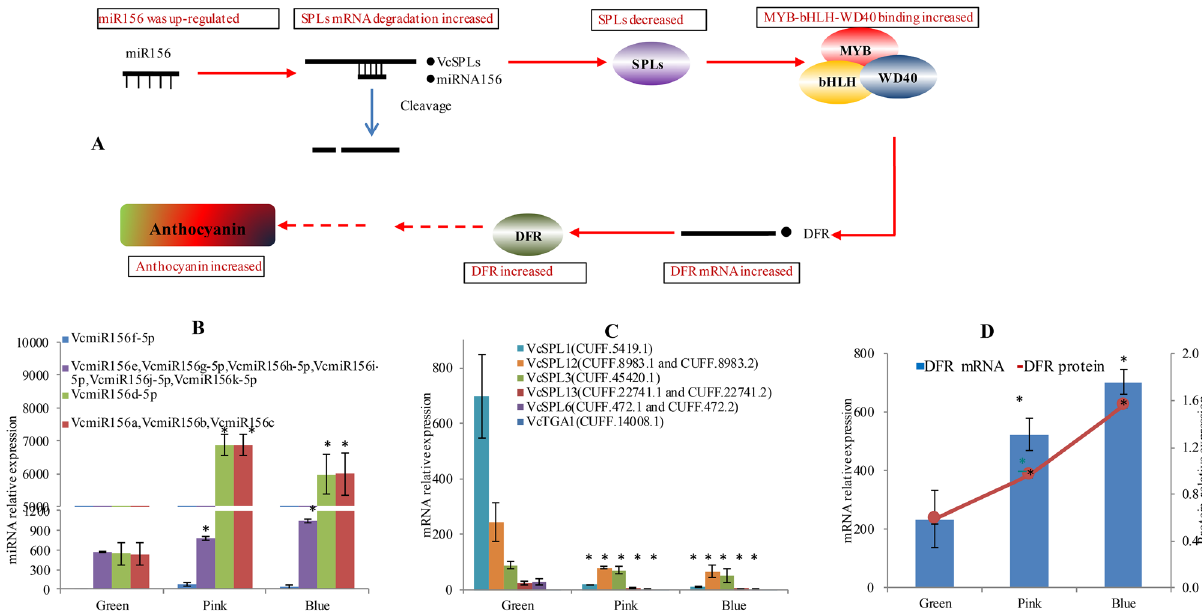
Figure 2. A potential pathway of the miR156-SPL module involved in anthocyanin biosynthesis during fruit maturation. (A) VcmiR156-VcSPLs regulated dihydroflavonol 4-reductase (DFR), a gene responsible for anthocyanin biosynthesis by down-regulating SPLs and disturbing a MYB-bHLH-WD40 transcriptional activation complex; the relative expression of (B) miRNA156 and (C) their target SPLs at the RNA level; (D) the relative expression of DFR at both RNA and protein level. Error bars represented standard errors from three biological replicates (ten fruit as one replicate). "*" indicates the differences between green, pink and blue phases are significant (T test; *:P <